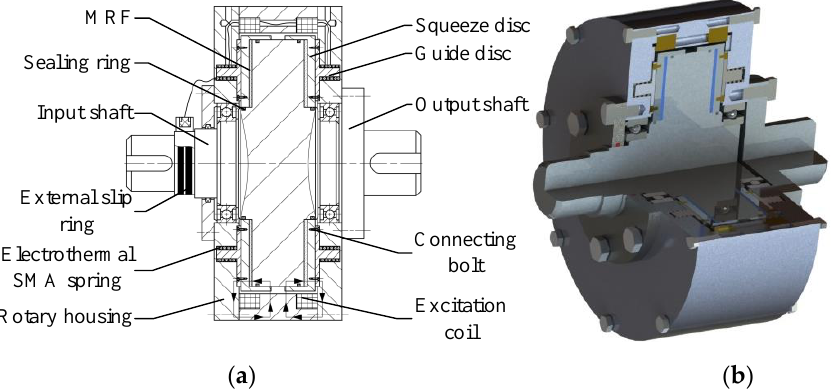
Figure 1. Working principles of MRF transmission device. ( a ) 2D structure diagram and ( b ) 3D structure diagram.